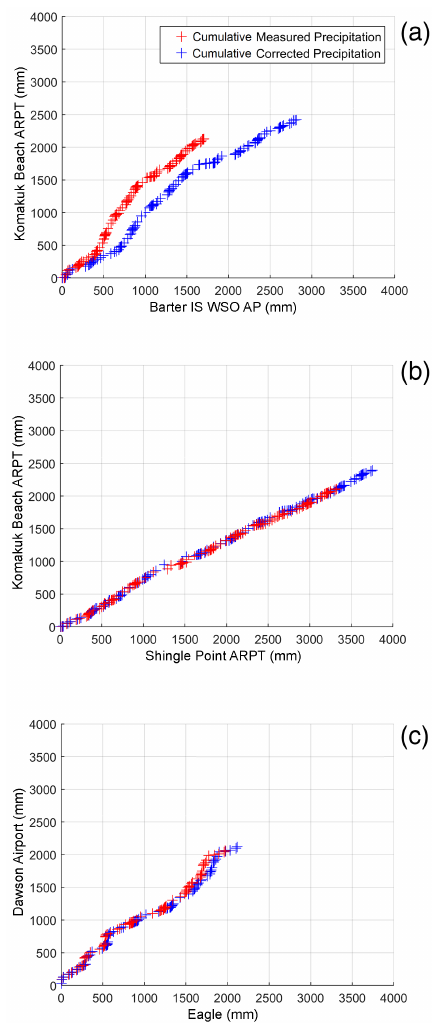
Figure 11. Double mass curves between station pairs. The red colour shows the warm months, and blue represents the cold months. The top and the central plots compare the stations for the northern group, and the bottom one is the central station comparison across the